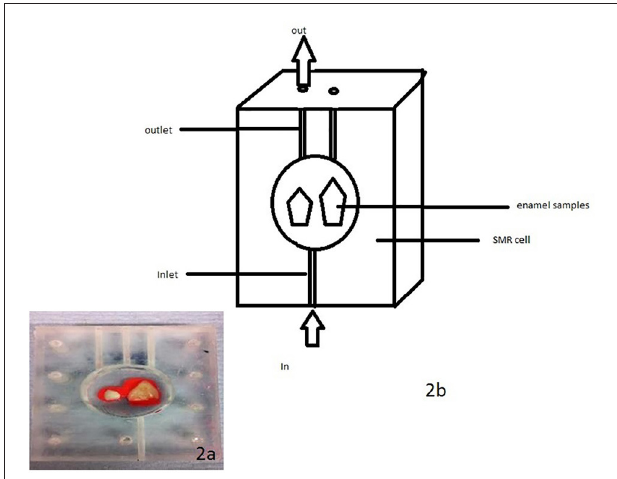
FIGURE 2 | (a,b) A photo and schematic diagram of human enamel blocks in an SMR cell with figure (b) showing the flow of acid into and out of the